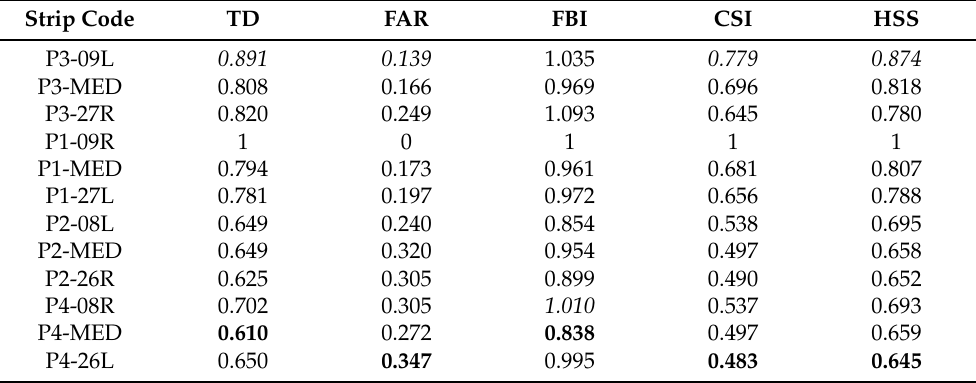
Table 3. Examples of scores for a perfect LVP forecast defined by P1-09R. See Table 1 and Figure 1 for the name and location of visibility sensors. The worst scores are shown in bold and the best scores are shown in